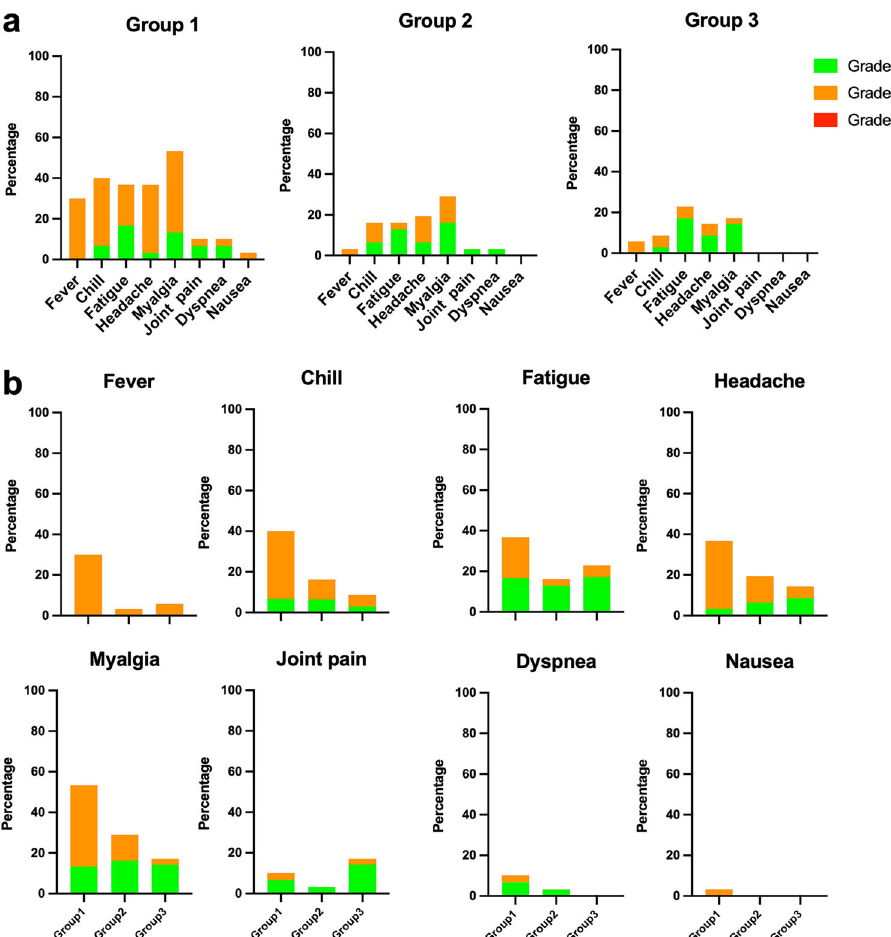
Fig. 3 Solicited systemic adverse reactions in 7 days after boosting. One in fi ve dosages of viral vector vaccine was delivered intradermally 4 – 8 weeks (Group2) and 8 – 12 weeks (Group3) after 2 doses of inactivated SARS-CoV-2 vaccines. Intramuscular viral vector boost, with a 4 – 8-week interval after the last vaccination (Group 1), was also included as controls. a The systemic adverse events were graded as per medical requirements and presented as percentages. The self-limited, systemic reactions were grade 1 (green). The reactions requiring medications were grade 2 (orange), and those needing medical attention were grade 3 (red). No grade 3 reactions were observed. b Systemic reactions were plotted separately to compare the three vaccinated groups.